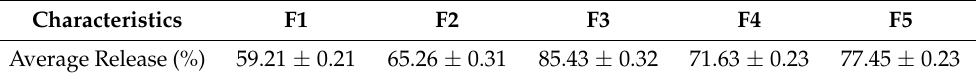
Table 3. In vitro release study of esomeprazole-loaded hydrogel formulations.